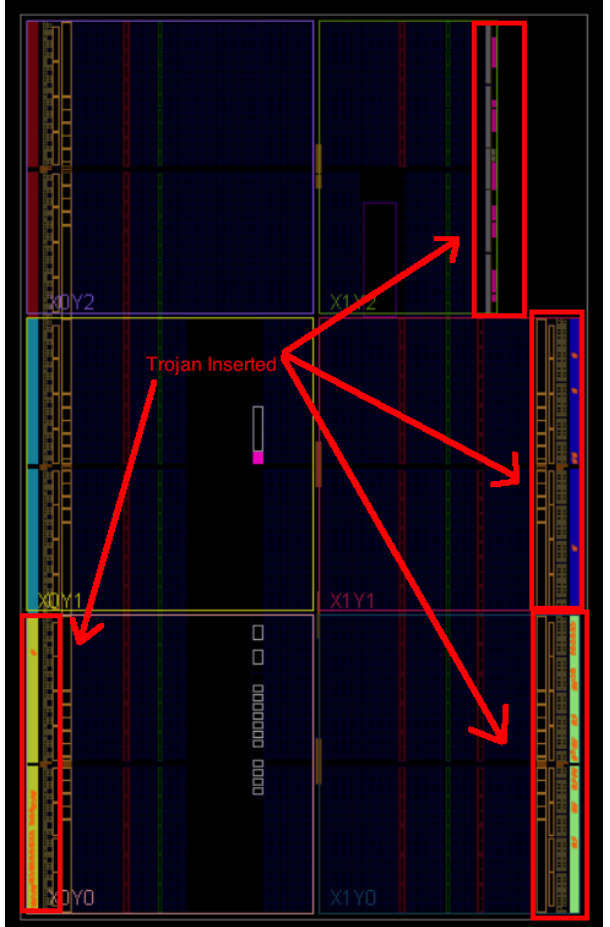
Figure 7. Floorplan-trojan-inserted.